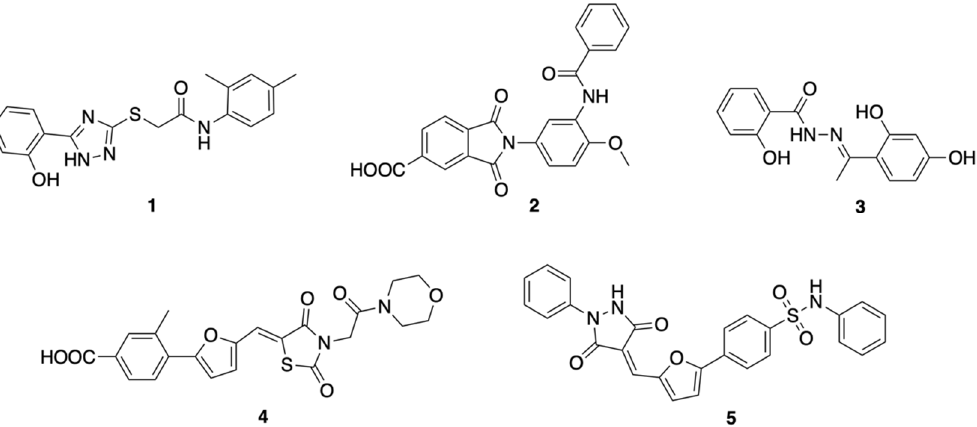
Figure 2. Micromolar inhibitors of norovirus RdRp previously identified by our group through a docking-based virtual screening approach [18]. docking-based virtual screening approach